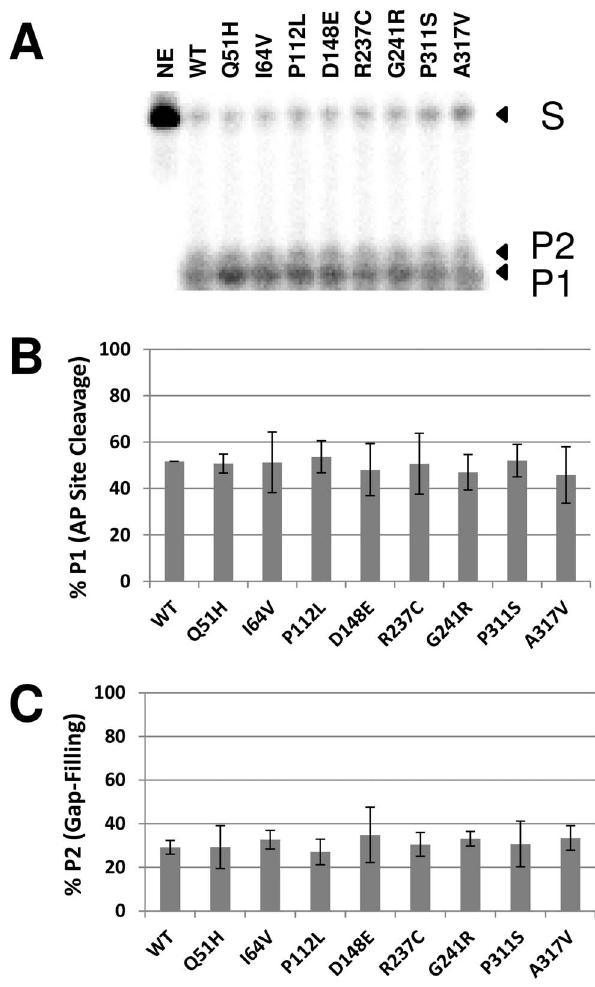
Figure 6. Reconstitution assay using purified BER proteins. ( A ) Wild-type (WT) and variant APE1 proteins were incubated with UDG and POL b with 32 P-labeled 34U DNA substrate (1 pmol), and the reactions were resolved on a urea-polyacrylamide denaturing sequencing gel. The non-incised substrate (S), AP site incision product (P1), and gap- filling extension product (P2) were visualized and quantified using standard phosphorimaging analysis. NE=no enzyme. ( B ) Relative AP site cleavage efficiency. Shown are the averages and standard deviations of 4 independent reactions. ( C ) Relative gap-filling activity. Shown are the average and standard deviation of 4 independent